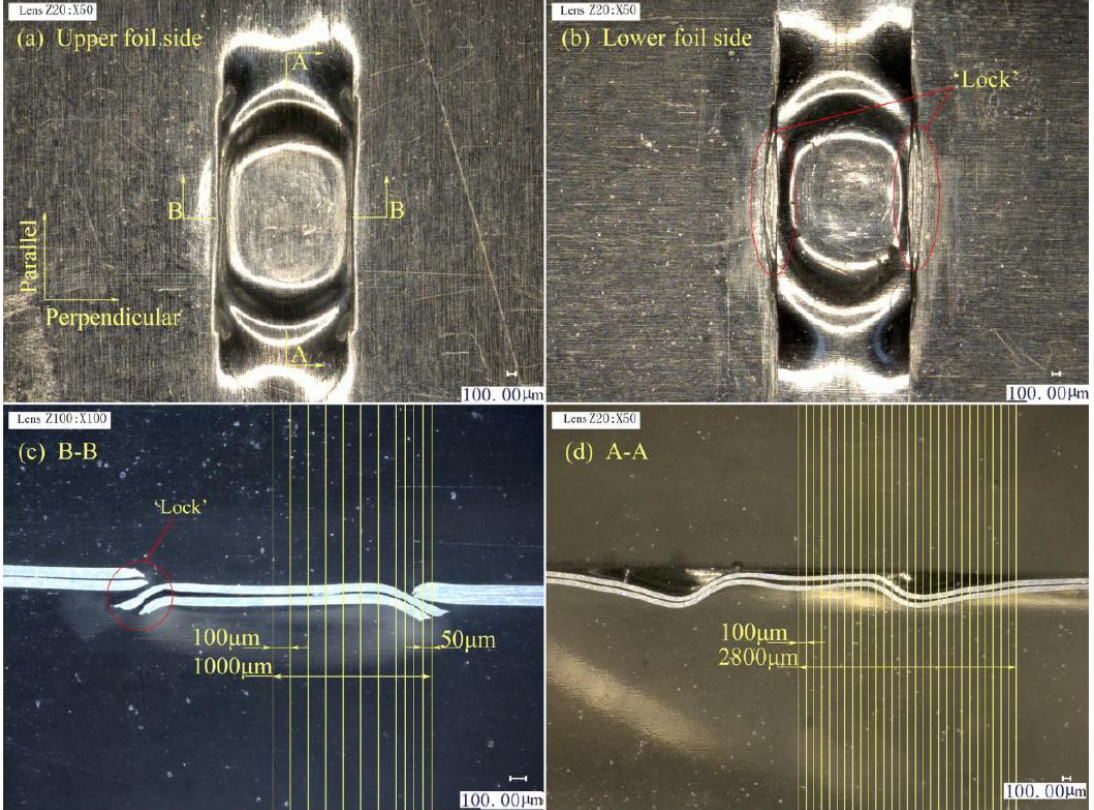
Figure 13. Joint formation in Stage 3: ( a ) upper foil side appearance; ( b ) lower foil side appearance; ( c ) B–B section on perpendicular symmetry plane; and ( d ) A–A section on parallel symmetry plane.